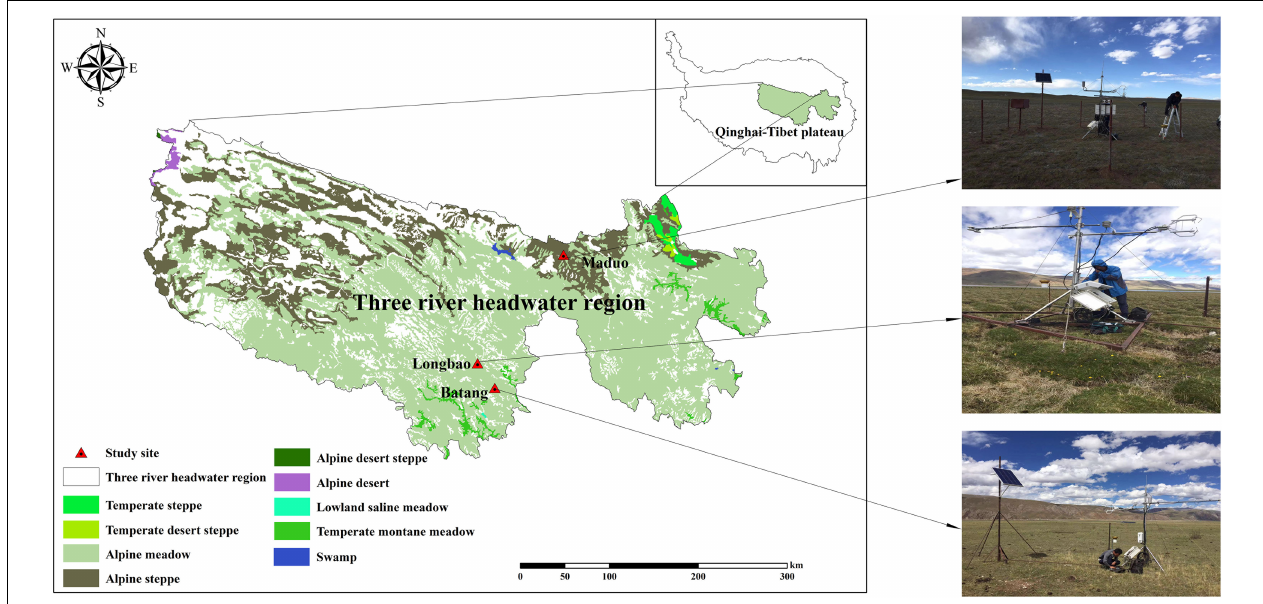
FIGURE 1 | Grassland types and location of the three sites in the Three River Headwater Region, Qinghai–Tibetan Plateau.